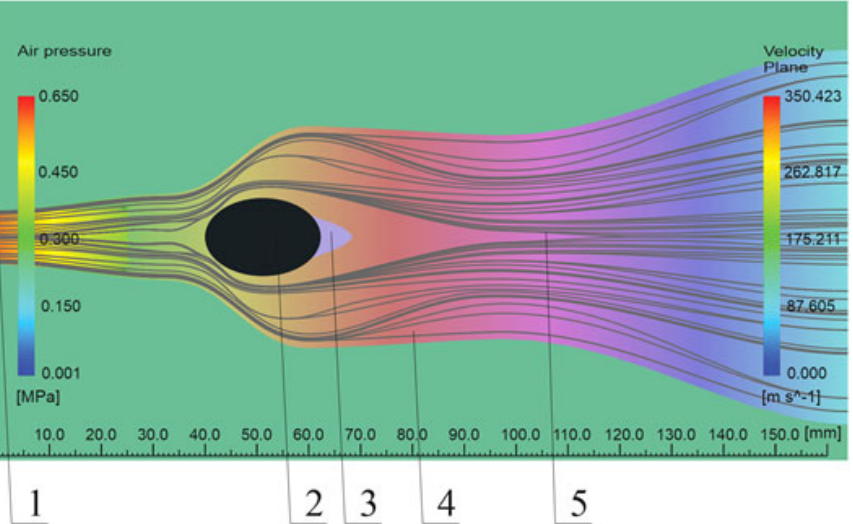
Figure 3. The model of the airflow around a solid body (electrode) at arc metallization: 1—the section with the highest pressure on the edge of the nozzle; 2—a solid body (imitator of an electrode at arc metallization); 3—the section with the highest pressure drop (depression section); 4—airflow; 5—the section where the airflow becomes dense.